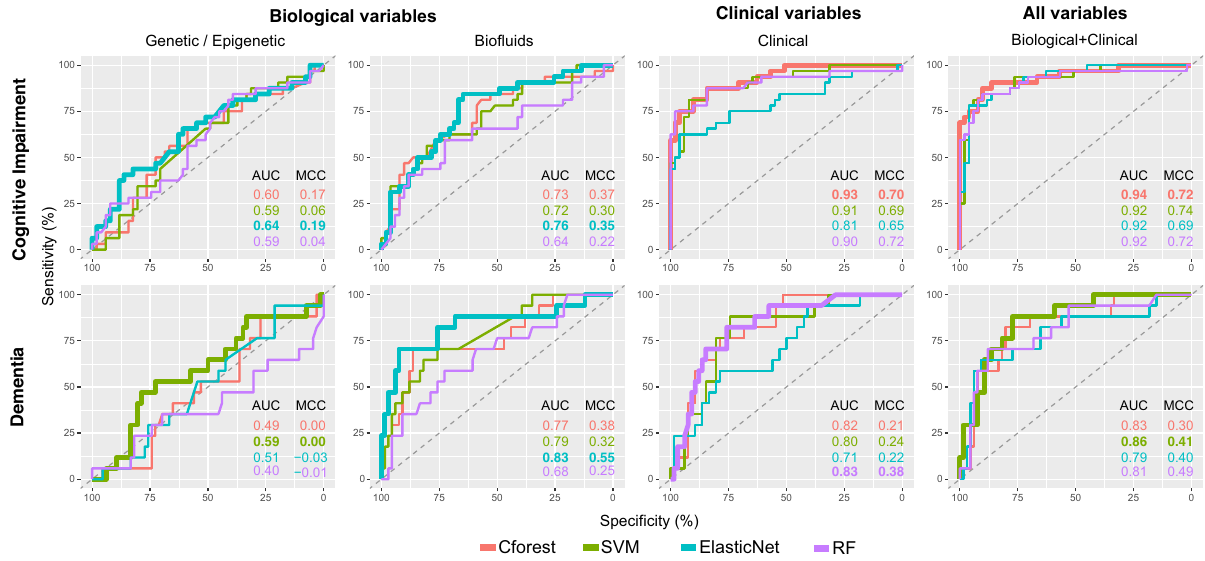
Fig. 2 Receiver operating characteristic plots for predicting cognitive impairment and dementia using selected clinical, genetic/ epigenetic, and bio fl uid variables. ROC curves displayed in grid with rows as cognitive outcome and columns as variable subset. Colored by ML algorithm with the highest AUC for each outcome and variable set displayed as a thicker line. AUC and MCC metrics displayed as text for each plot. ROC receiver operating characteristic AUC area under the curve, MCC Matthews Correlation Coef fi cient, ML machine learning, SVM Support Vector Machines, Cforest Conditional Inference Random Forest, RF Random